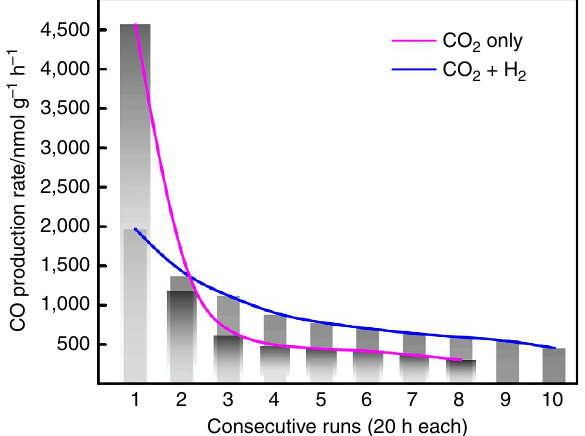
Figure 2 | Light-driven CO 2 reduction. CO production rates (pure 13 CO 2 in the batch reactor at 150 (cid:2) C) for eight cycles, and CO production rates ( 13 CO 2 and H 2 with 1:1 ratio in the batch reactor at 150 (cid:2) C) for 10 cycles, both under light (one sun) with the same total pressure of 27p.s.i.